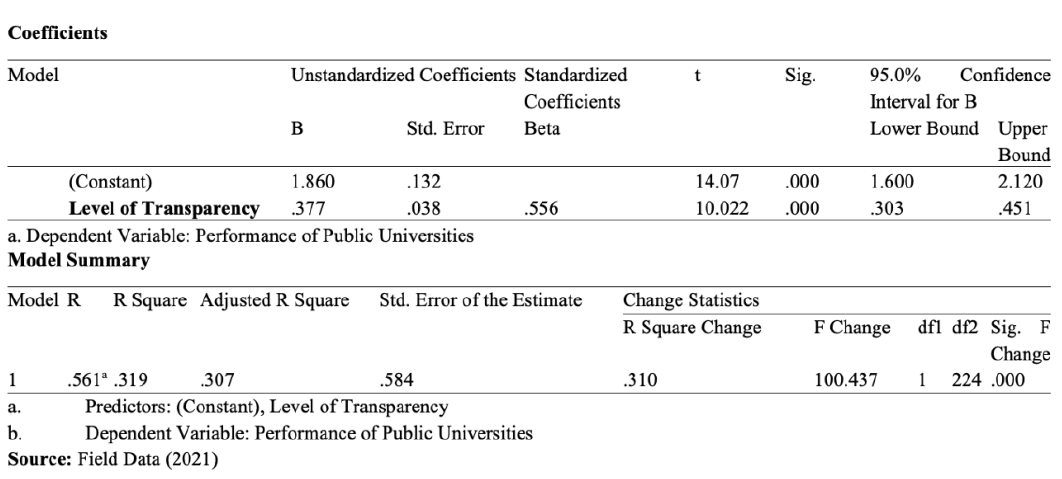
Table 4: Regression Results for the Effect of Transparency on Performance of Public Universities.